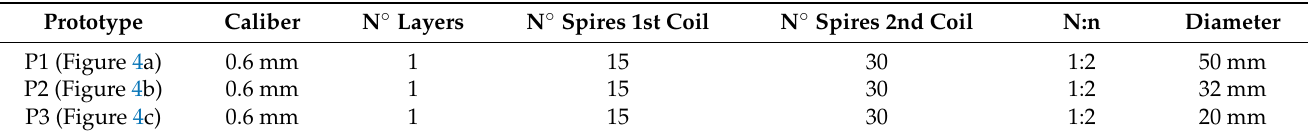
Figure 4. Coils used in our developed sensor: ( a ) P1, coil of 50 mm;( b ) P2, coil of 32 mm; ( c ) P3, coil of 20 mm. of 20 mm. Table 2. Prototypes to measure soil moisture. Table 2. Prototypes to measure soil